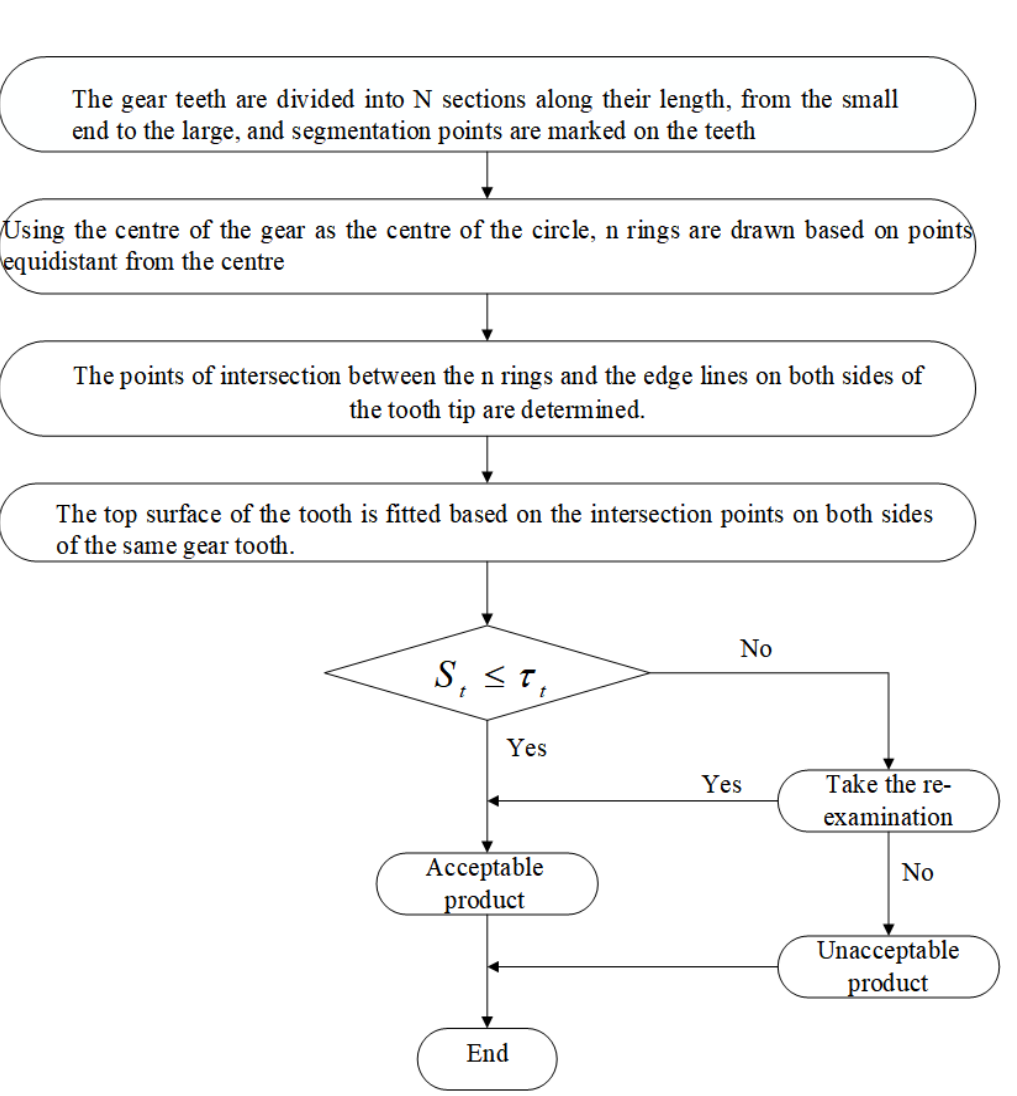
Figure 1. Flow chart for the coaxial multi-ring measurement method.